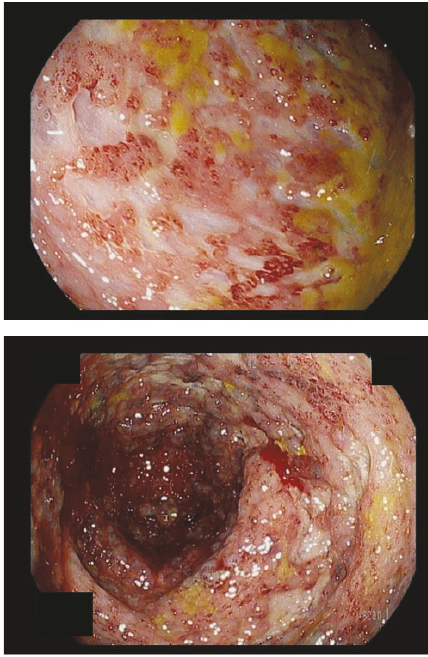
Figure 2: Endoscopic evaluation after failed trial on oral steroids. Severe colitis seen up to 40cm; further evaluation was limited given degree of inflammation.